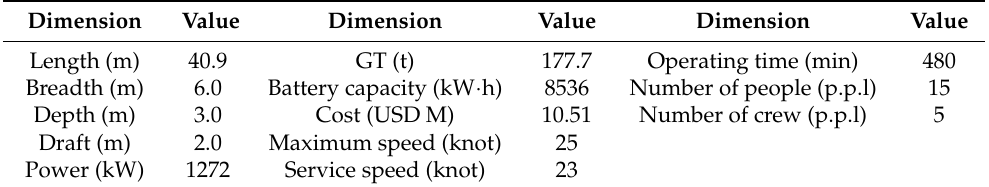
Table 4. Design decisions that are required to maintain the same level of functional capabilities as that of the operating ship.